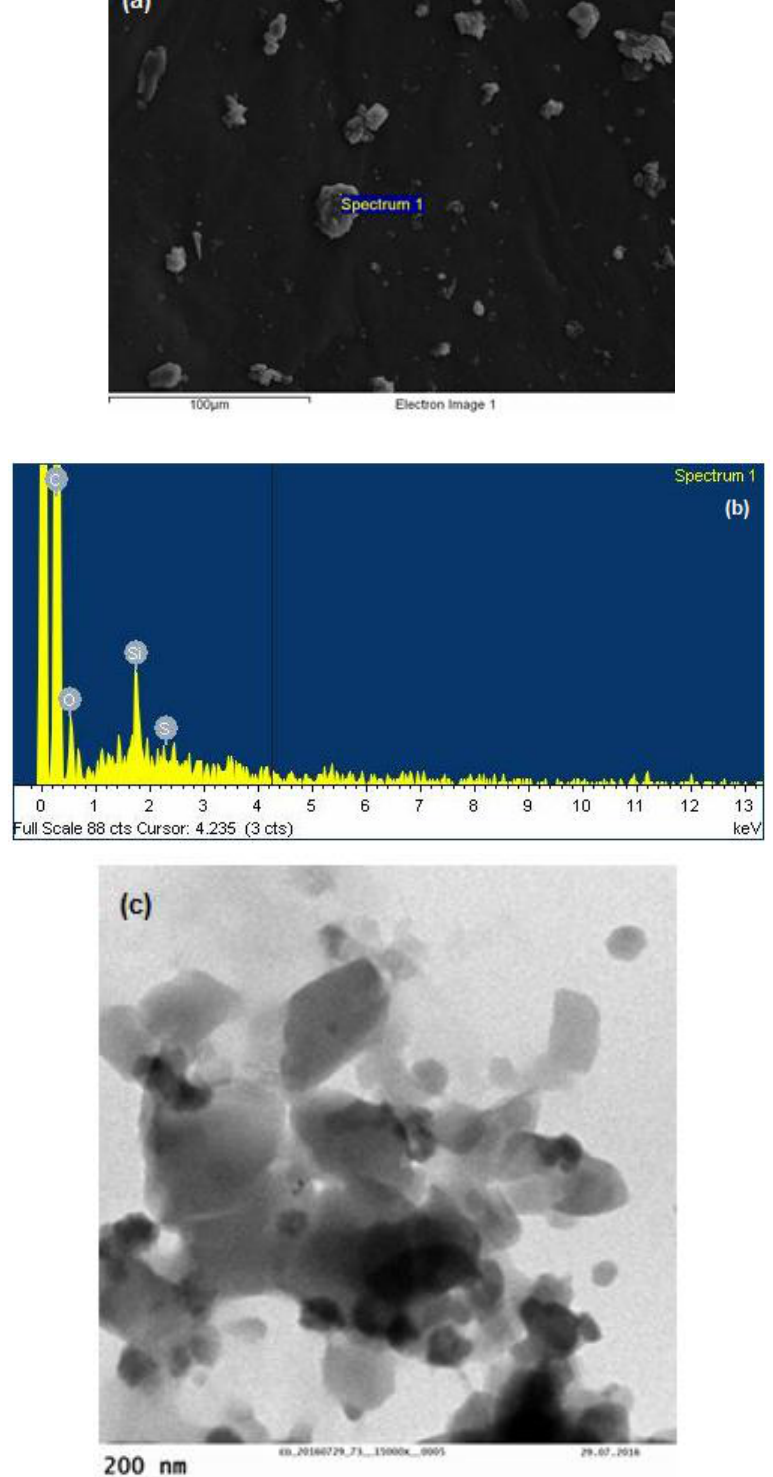
Figure 4. MCF/paliperidone-loaded nanoparticles coated with thiolated chitosan: ( a ) SEM micrograph, ( b ) EDX analysis, and ( c ) TEM micrograph. ( b ) EDX analysis, and ( c ) TEM